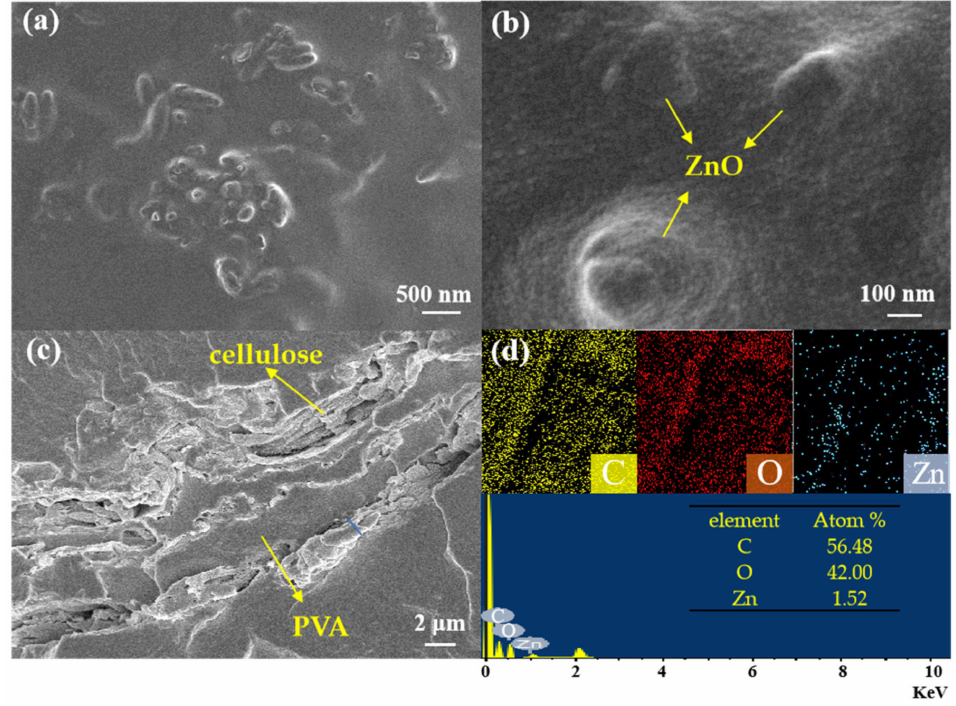
Figure 2. ( a – c ) SEM images of ZnPCP and ( d ) EDS mapping images of